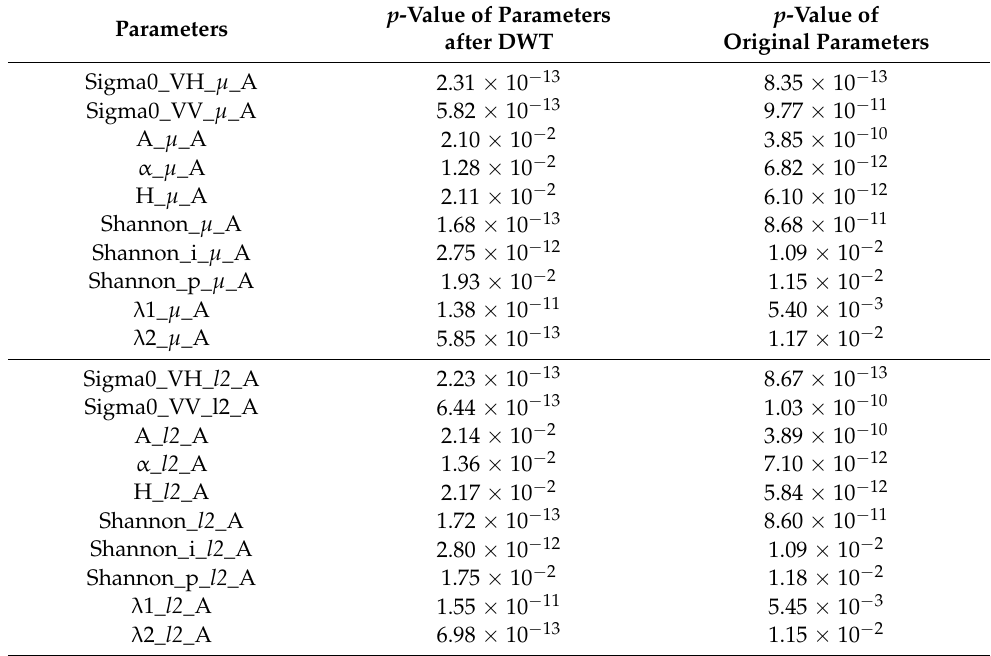
Table 8. p -value of the original parameters and the low-frequency components after DWT. Letter A after the parameter indicates the low-frequency component after